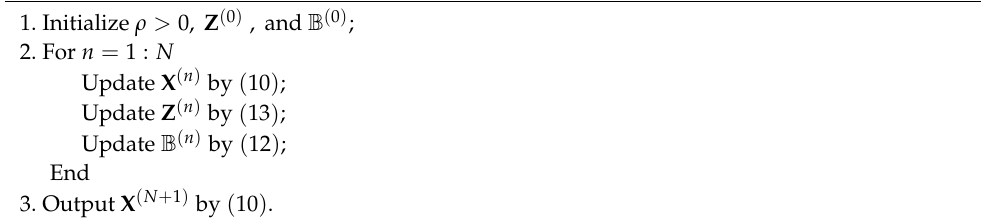
Algorithm 1: High-Resolution ISAR Imaging Based on PnP 2D ADMM.